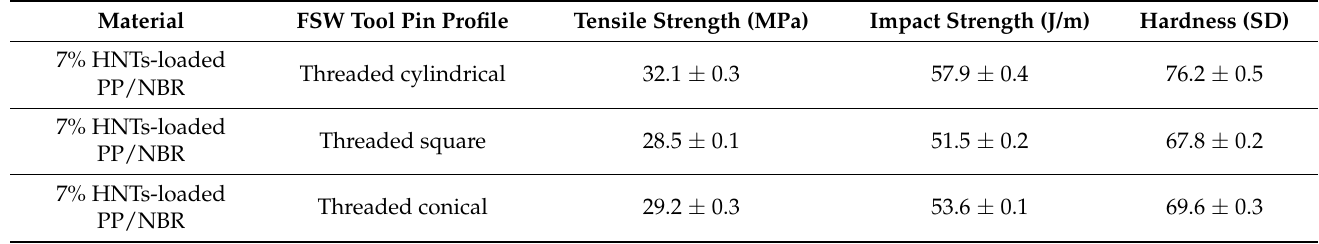
Table 4. Confirmation experiments using different pin